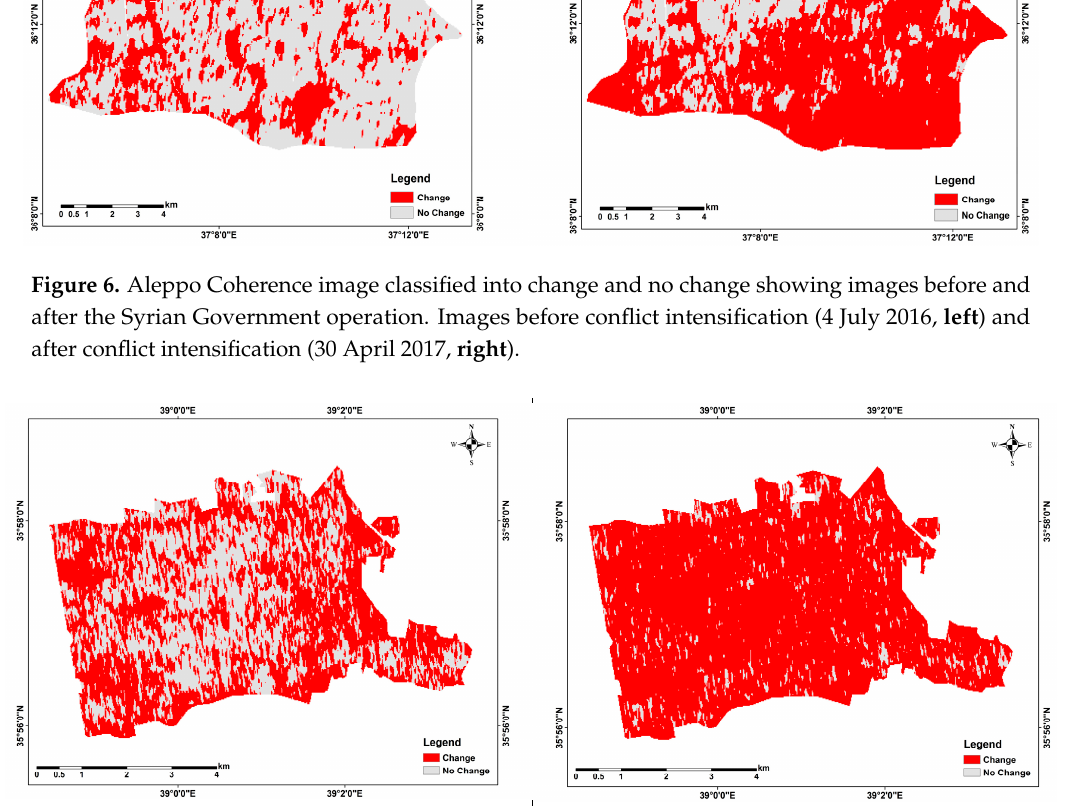
Figure 6. Aleppo Coherence image classified into change and no change showing images before and after the Syrian Government operation. Images before conflict intensification (4 July 2016, left ) and after conflict intensification (30 April 2017, right ).